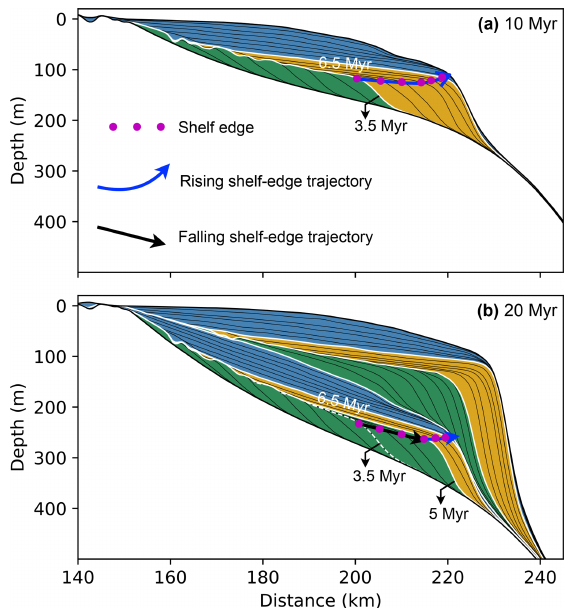
Figure 9. Stratal stacking pattern extracted at 10Myr (a) and 20Myr (b) . Between 3.5 and 5Myr, the shelf-edge trajectory changes from rising at 10Myr to falling at 20Myr, as a result of basement subsidence. The descending trajectory class thus extends to